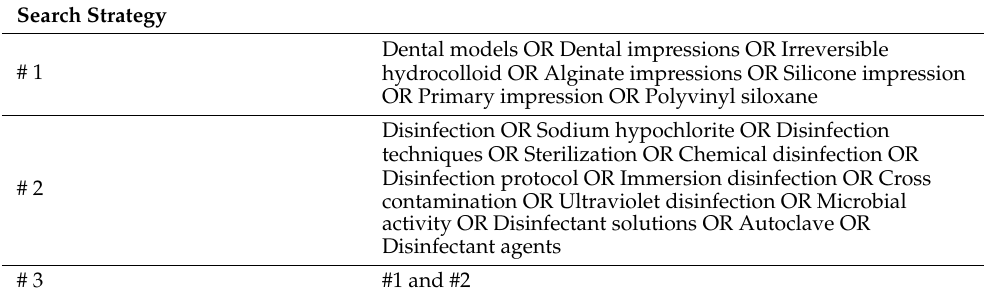
Table 1. Keywords used in search strategy. Search